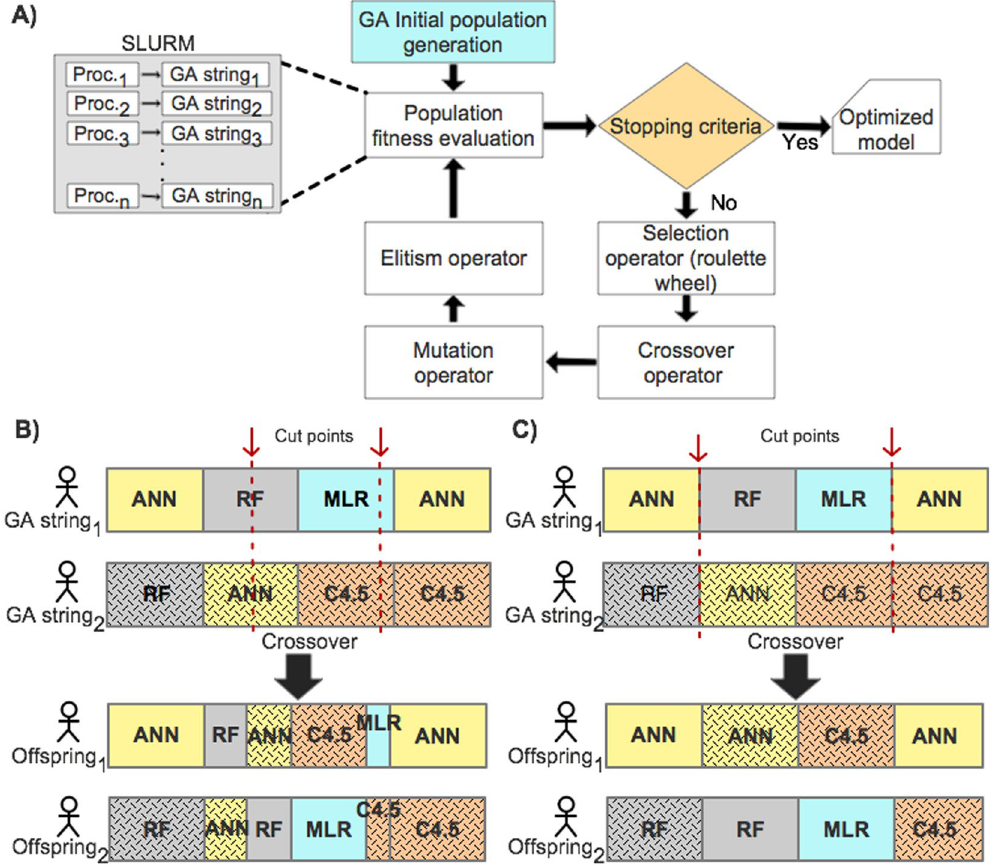
Figure 4. ( A ) Schematic representation of the GA execution. ( B ) Crossover inconsistencies when considering random cut points at an arbitrary bit. ( C ) Consistent crossover scheme, where cut values must be either at the beginning or end of an encoded